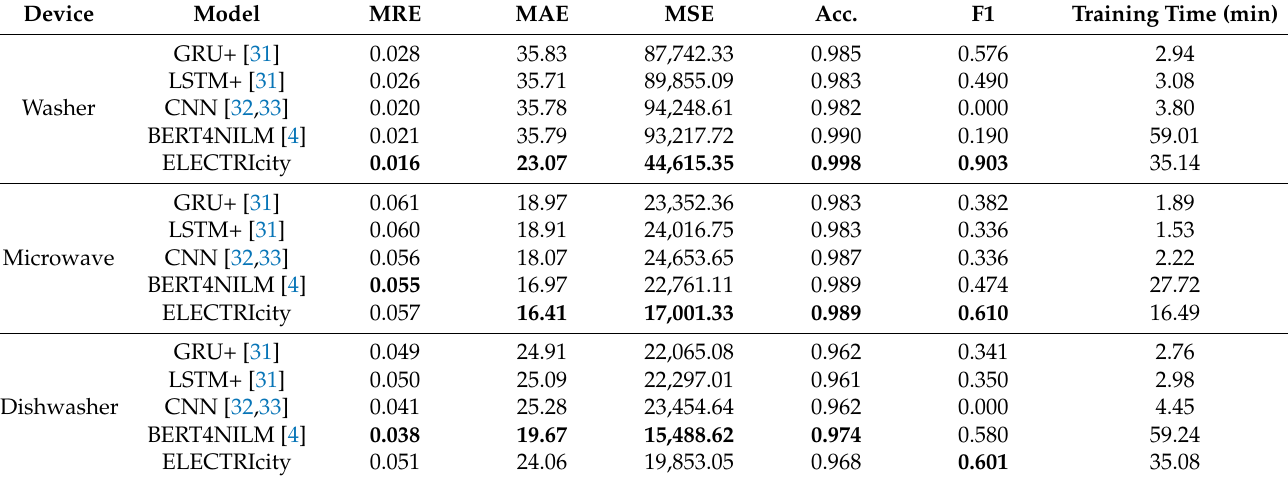
Table 3. Comparison of ELECTRIcity’s model performance to other techniques in the REDD